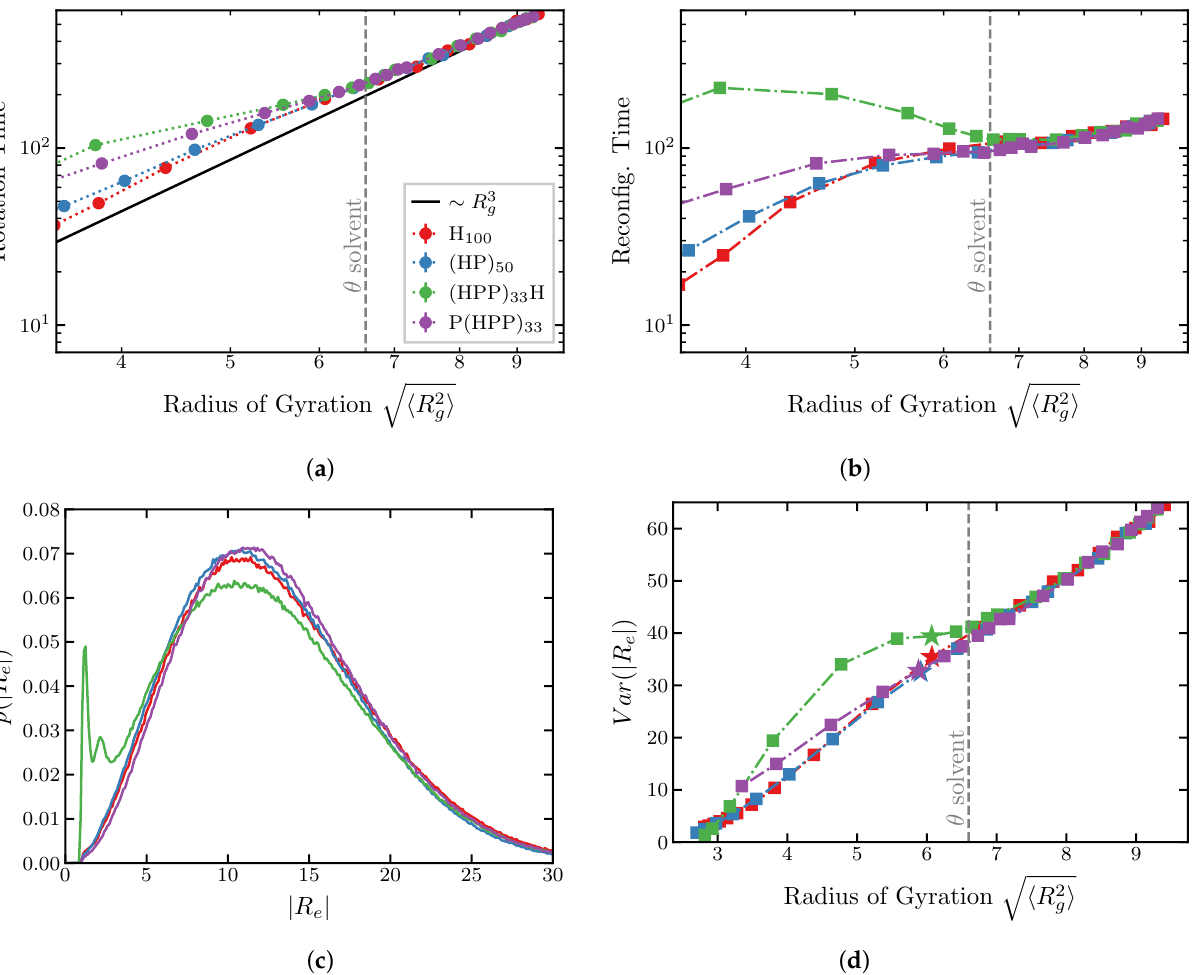
Figure 7. Relaxation times of the end-to-end vector and distance. ( a ) Relaxation time of the end- to-end vector (“rotation time”) and ( b ) the end-to-end distance (“reconfiguration time”) for the different sequences indicated in the legend of ( a ). The x-axis shows the mean square radius of gyration controlled by monomer cohesiveness in the simulations. ( c ) End-to-end distance probability distribution. Red line: H 100 sequence; (cid:101) /kT = 0.9. Blue line: (HP) 50 sequence; (cid:101) /kT = 3.2. Green line: (HPP) 33 H sequence; (cid:101) /kT =5.4. Purple line: P(HPP) 33 ; (cid:101) /kT = 5.6. The radius of gyration R g 6 0.1 for all sequences (see ( d )). ( d ) Variance of the end-to-end distance as a function the ≈ ± radius of gyration of the chains. Stars indicate the radii of gyration of the sequences for the parameter values in ( c ). Deviation of the green line from the others below the θ -point reflect the emergence of the secondary peak in the end-to-end distribution in ( c ). See